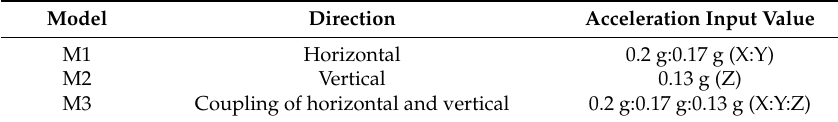
Table 2. The conditions of peak ground acceleration (PGA).